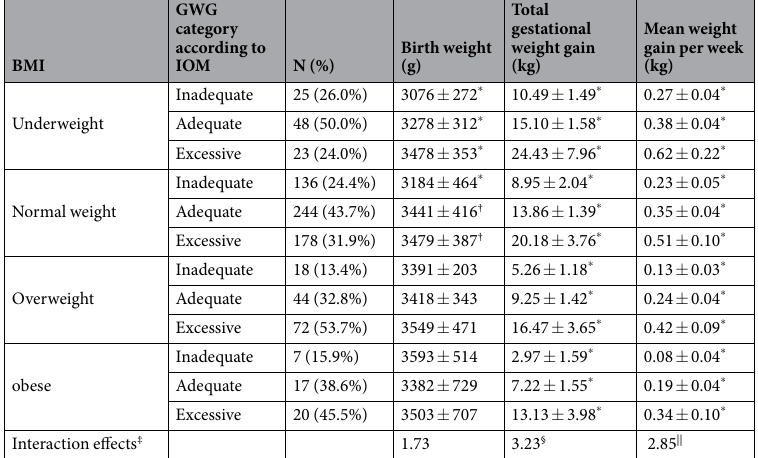
Table 2. Variation of birth weight, total GWG and mean weight gain per week with GWG category in each of the four pre-pregnancy BMI groups. Data presented as n (%) or mean ± standard deviation. BMI, body mass index; GWG, gestational weight gain; IOM, Institute of Medicine. * P < 0.05 vs. both the other GWG groups; † P < 0.05 vs . inadequate GWG group; ‡ the F-value for the interaction effects; § interaction effect of BMI * GWG on total gestational weight gain, P < 0.05; || interaction effect of BMI * GWG on mean weight gain per week, P < 0.05.